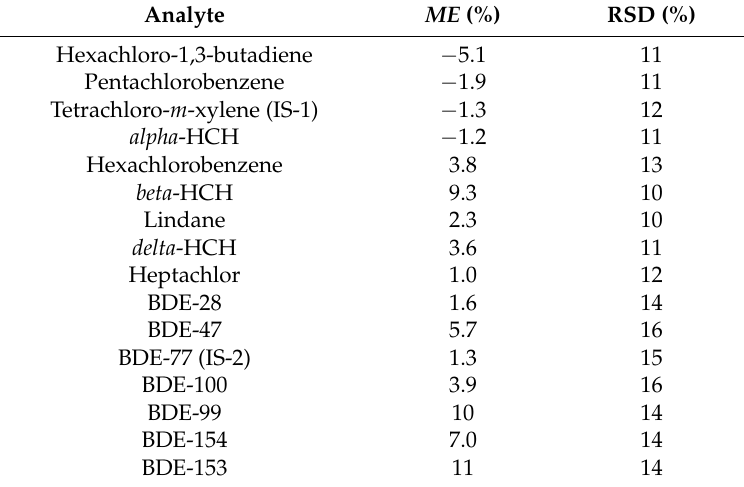
Table 2. Matrix effect ( ME ) evaluation for the studied analytes in the spiked QuEChERS extracts after DLLME and H 2 SO 4 clean-up ( n = 5).